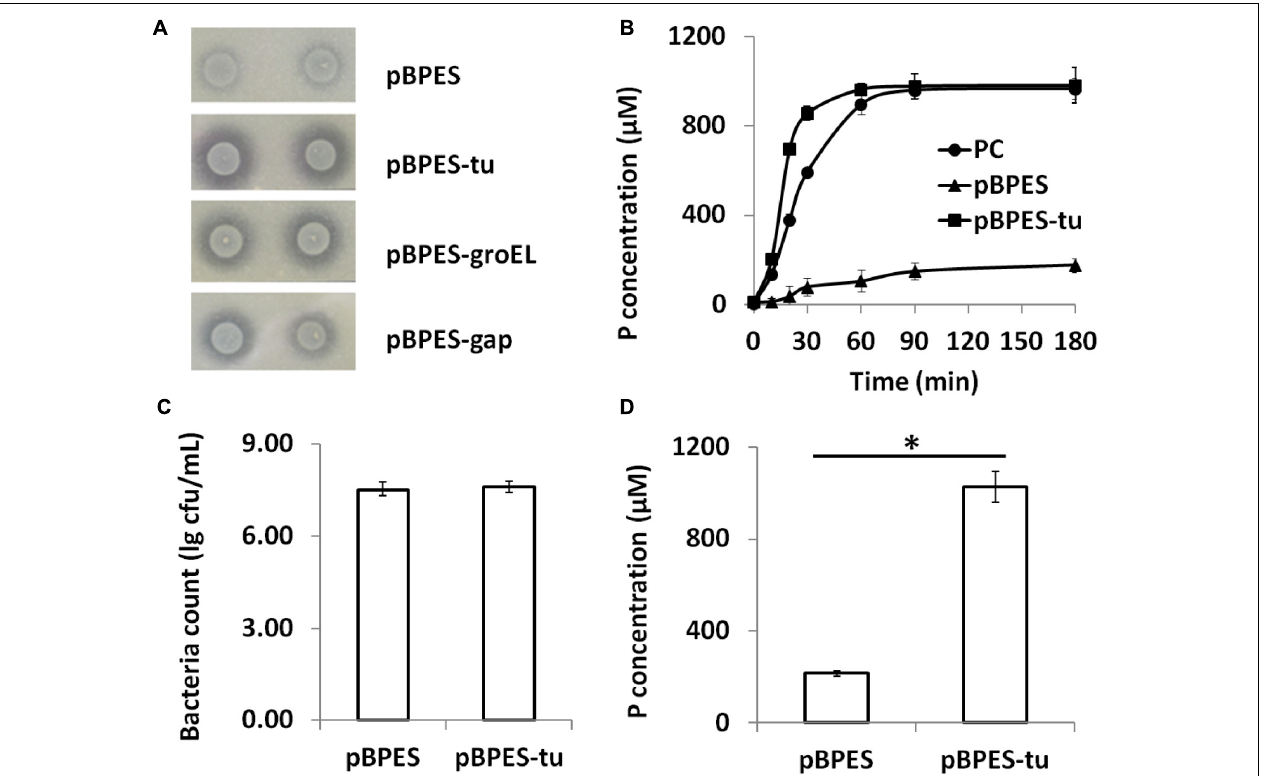
FIGURE 3 | Phytate degradation by B. longum JCM 1217/pBPES-tu in vitro. (A) degradation of phytate-Ca on solid phytase screen medium by spotted bacterial colonies harboring plasmid pBPES or pBPES-tu; (B) degradation of phytate from maize powder in liquid phase by CFMs of different recombinant strains or commercial phytase; (C) bacteria counts of different recombinant strains grown in the modified RCM plus 2% maize powder; (D) degradation of phytate from maize powder by inoculation of different recombinant strains into the modified RCM. All data were mean of three independent experiments with triple replicates and expressed as mean ± SD. Statistical analysis for degradation of phytate was performed using Student’s t -test ( ∗ significant with P < 0.01). CFM, cell free medium; RCM, reinforced clostridia medium; PC, 1 FTU/mL commercial phytase.